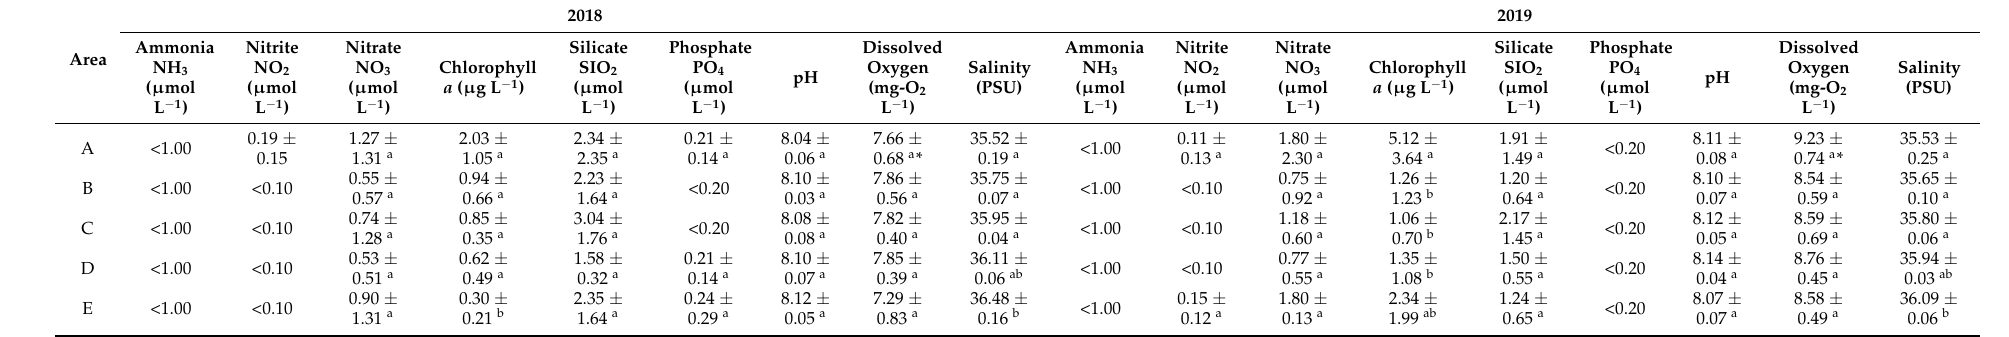
Table 2. Mean ± standard deviation values of ammonia, nitrite, nitrate, chlorophyll a , silicate, phosphate, pH, dissolved oxygen, and salinity were determined for the 2018 and 2019 surveys for the surface level (2 to 7 m depth). Values below a determined concentration are the limit of quantification for each parameter analyzed are signaled with the symbol <. Note: values sharing a different letter were significantly different ( p < 0.05) between the area for each year of a field survey; * represents statistically significant differences between the field surveys in the different years ( p <